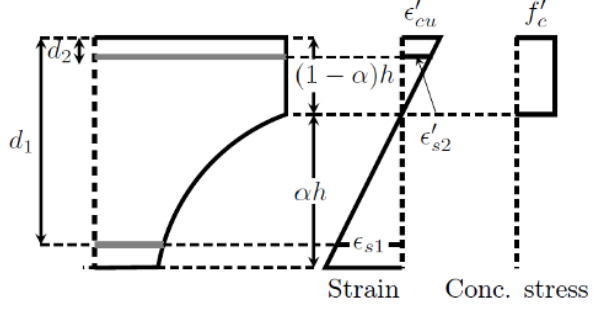
Figure 5. Strain